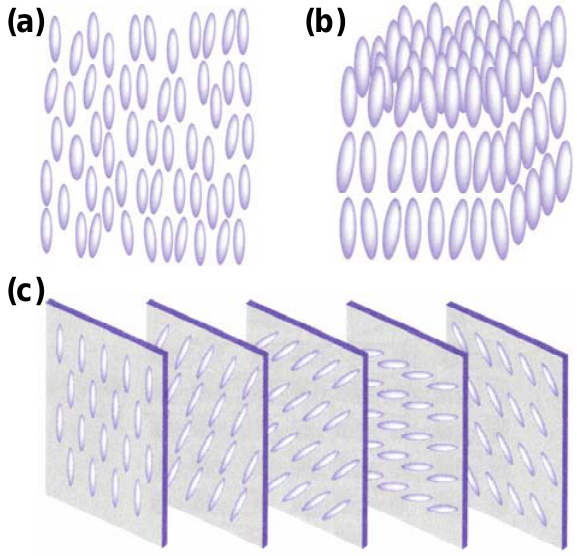
Figure 2. Phases of liquid crystals: ( a ) nematic phase; ( b ) smectic phase and ( c ) cholesteric